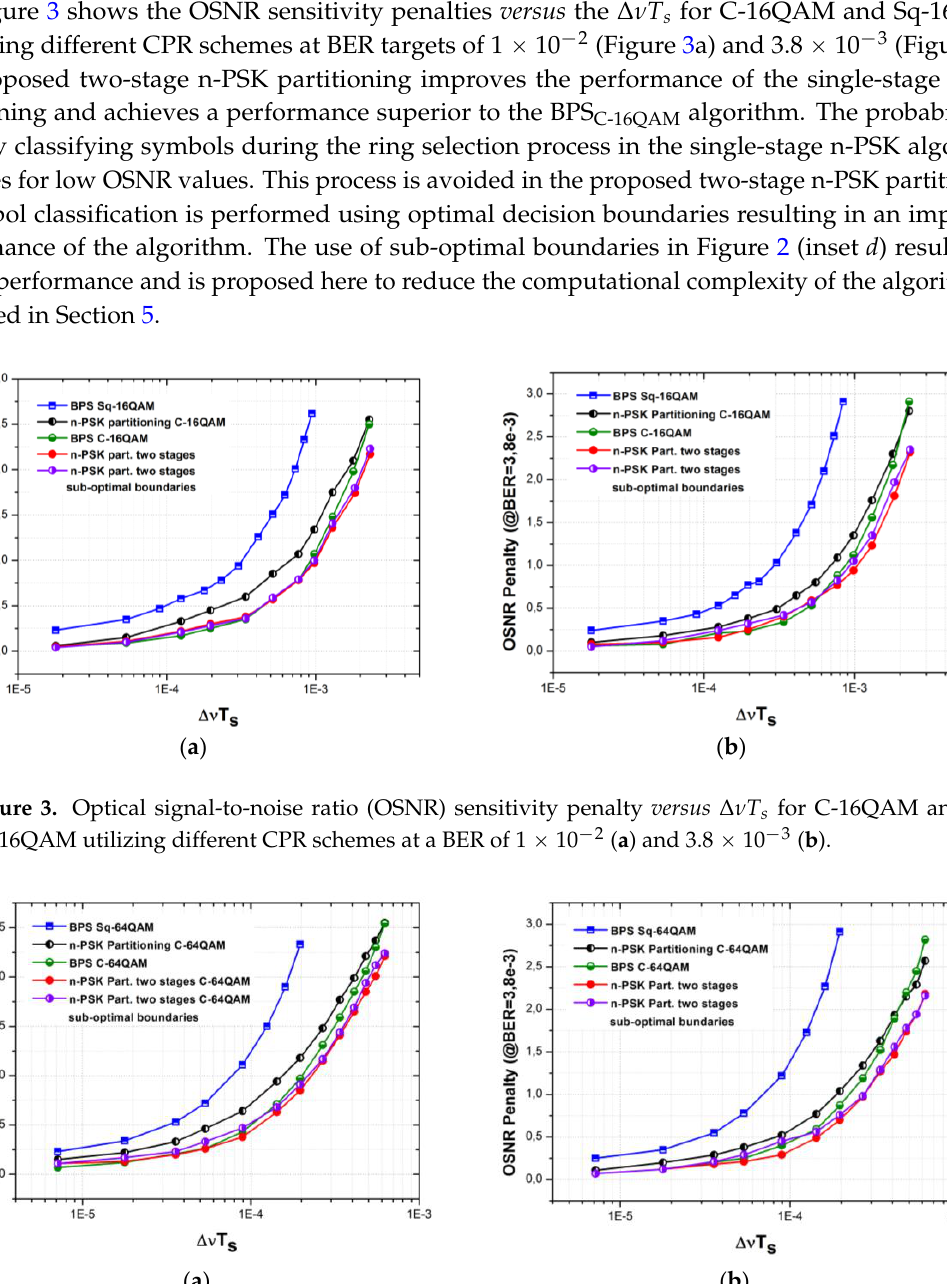
Figure 4. OSNR sensitivity penalty versus Δ νT s for C-64QAM and Sq-64QAM utilizing different CPR schemes at a bit error rate (BER) of 1 × 10 −2 ( a ) and 3.8 × 10 −3 ( b ).